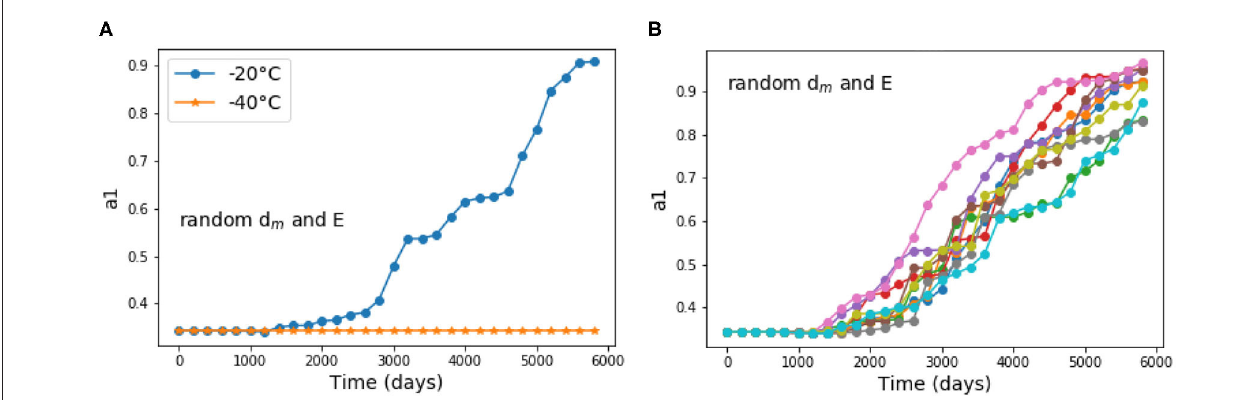
FIGURE 10 | Modeled evolution of a (2) 1 as a function of time, based on 1000 random initial orientations, following the homogeneous stress hypothesis (Sachs), with initial density varying randomly between d m ( min ) and d m ( max ) (Table A1) and stress concentration E varying randomly between 1 and 10. (A) Comparison between the two temperature conditions of Point Barnola ( − 40 ◦ C) and EastGRIP ( − 20 ◦ C) for on single run. (B) Ten runs performed for EastGRIP conditions ( − 20 ◦ C). No variation between the runs is observed for Point Barnola